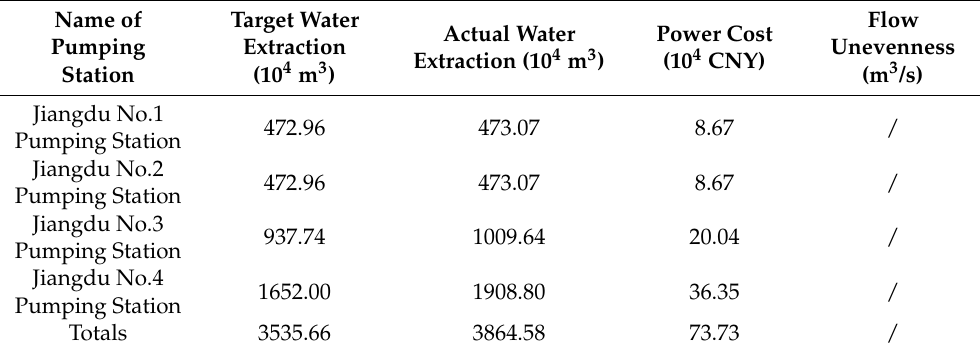
Table 5. Conventional operation results under average daily head 7.8 m and 80% water extrac- tion